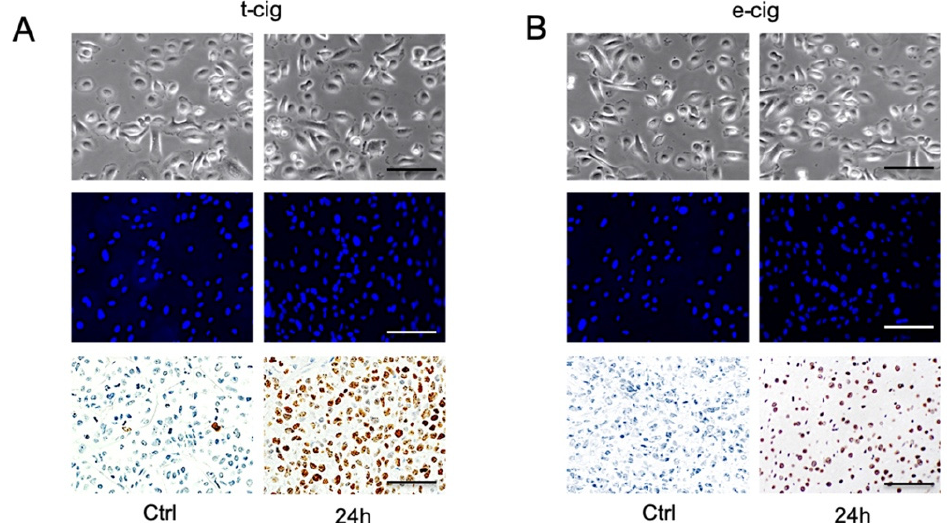
Figure 4. Apoptotic cells and their morphology measured by TUNEL assay and DAPI staining. ( A ) t-cig smoke and ( B ) aerosol e-cig. Phase-contrast microscopy ( upper ), DAPI staining nuclei ( middle ), and TUNEL-positive cells stained as dark brown ( lower ). Scale bar = 100 μ m.